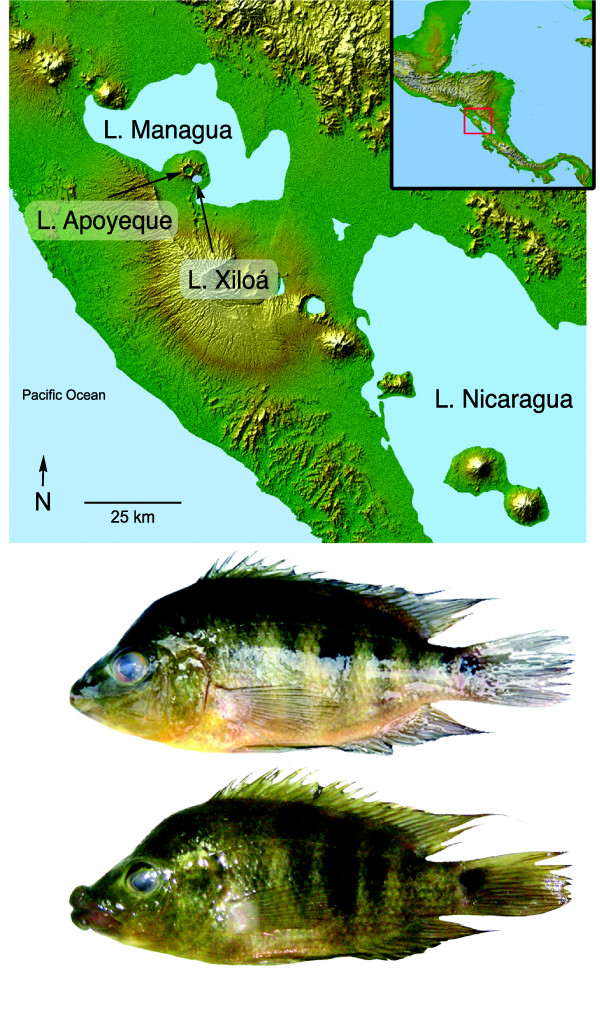
Relief map of Nicaragua showing the relevant lakes. Crater lake Apoyeque is located beside the great Lake Managua and the crater Lake Xiloá, in western Nicaragua, Central America. Two morphs of Midas cichlid are found in Apoyeque: one with fleshy lips (upper individual; 'thick-lipped') and the other with thin, normal A. citrinellus lips (lower individual; 'thin-lipped').